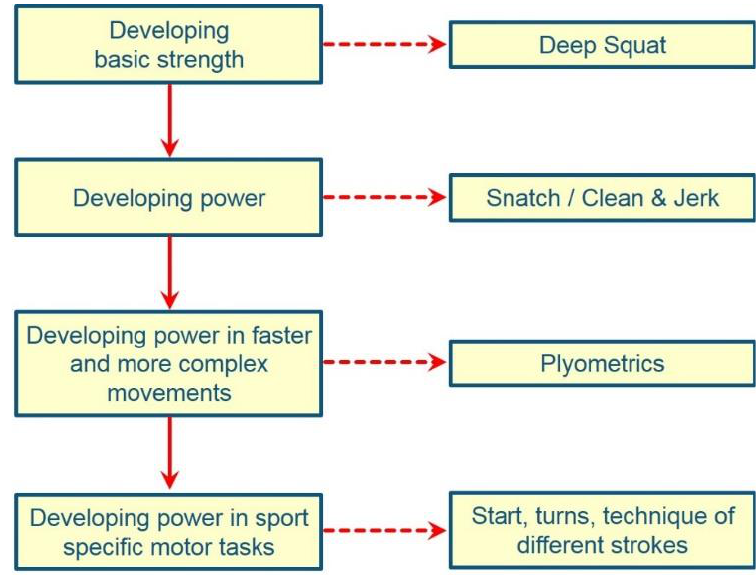
Figure 3. Exemplary notes on exercise